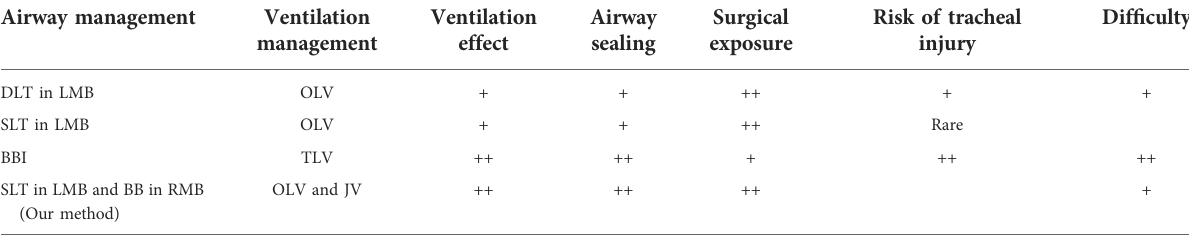
TABLE 2 Qualitative comparison of different lung separation techniques for the fi stula in the lower trachea and carina. Airway